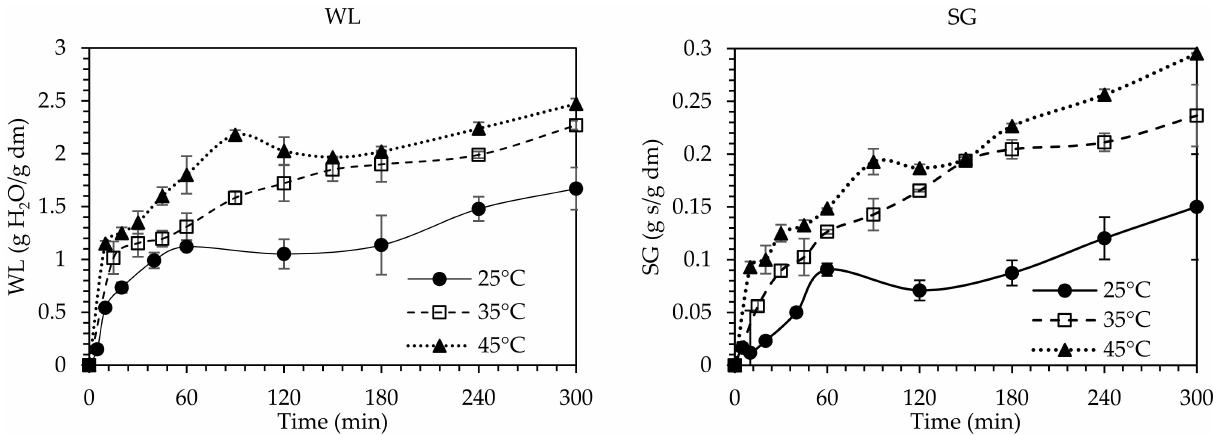
• ), 35 ◦ C ( (cid:3) ) and 45 ◦ C